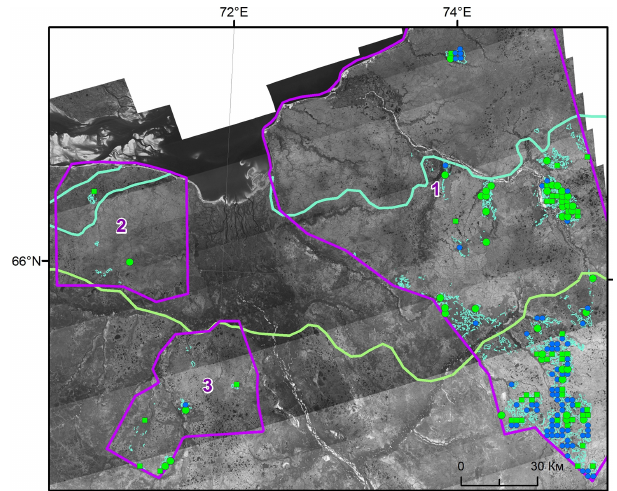
Figure 9. Illustration of the vegetation shift in dry tundra after the fire (time interval ca. 60 years). Blue circles – no shift, green squares – shift to woodlands, green circles – shift to forest. Cyan curve is the boundary between southern tundra and forest–tundra; green curve is the boundary between forest–tundra and northern taiga (source: topographic